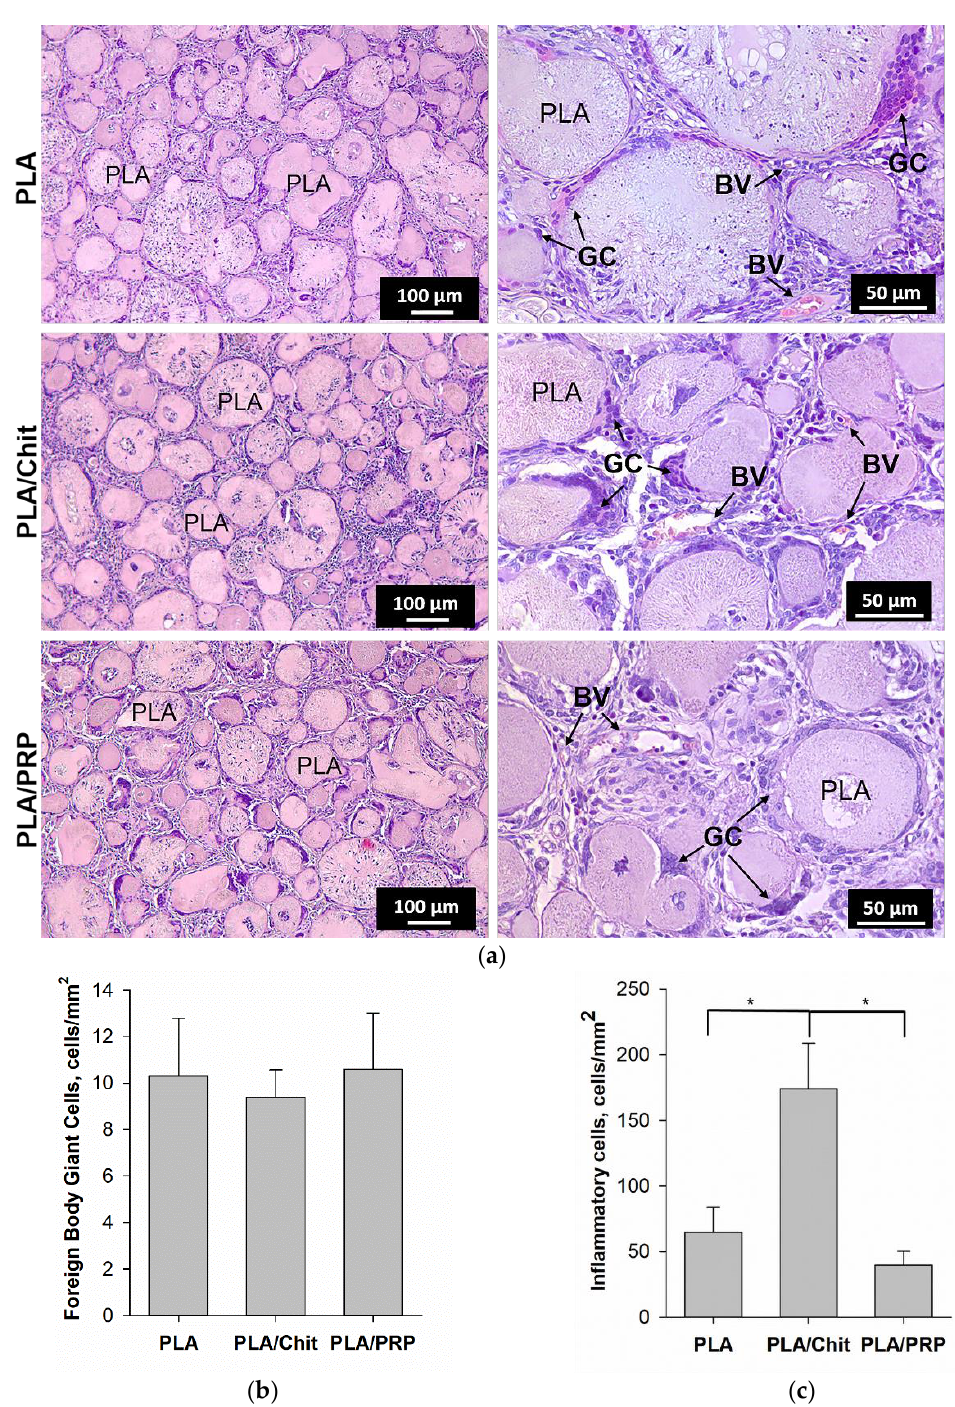
Figure 3. In vivo biocompatibility of matrices 28 days after intramuscular implantation: ( a ) tissue sections of the implantation area, H&E staining. Light microscopy. BV — blood vessel, GC — giant cells; ( b ) quantitative assessment of the resorption degree of the matrices; and ( c ) quantitative assessment of the degree of inflammation. * p < 0.05 (comparison between the groups).